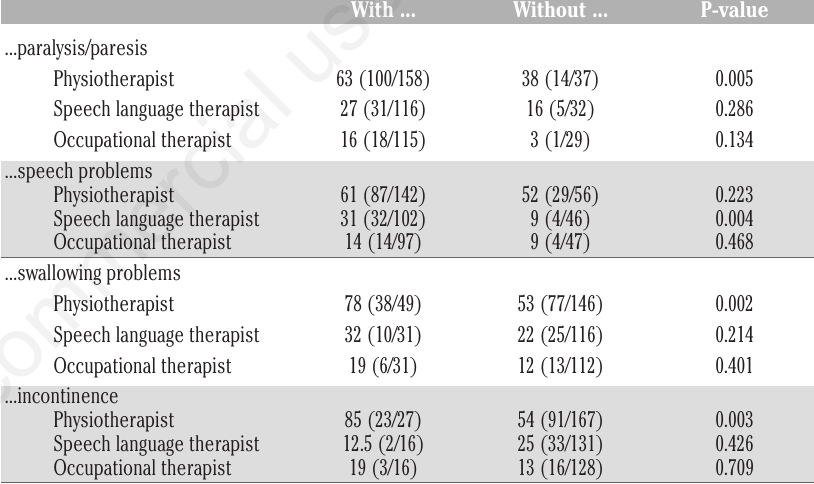
Table 1. Follow-up one month after the event and according to the neurological deficit in % (n/N).